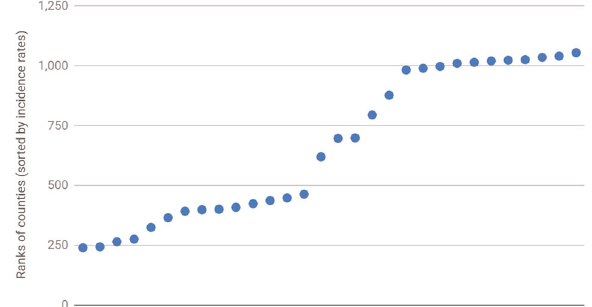
Fig. 3 Rank coverage by LL2015 counties. The plot shows ranks at which LL2015 counties appear in the list of all counties, which is sorted by decreasing order of incidence rates according to CDC. We observe near-uniform coverage between ranks 240 and 1055.